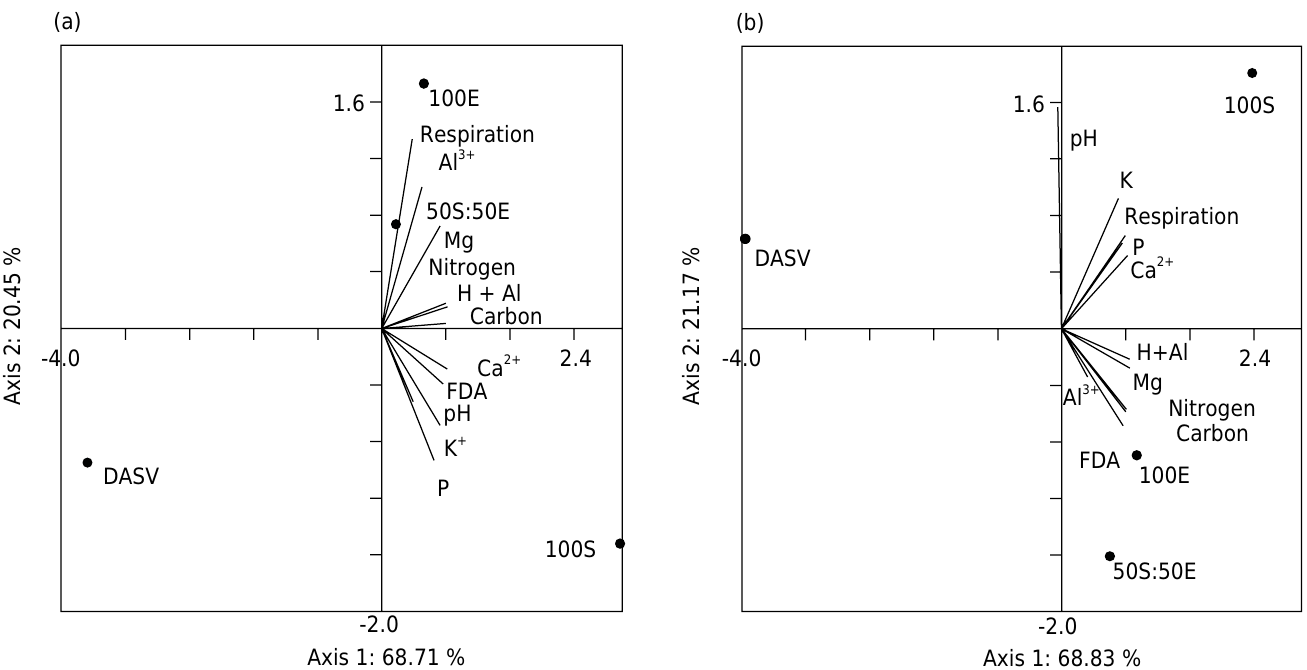
Figure 2. Principal component analysis integrating chemical and microbiological characteristics of degraded area with spontaneous vegetation (DASV) and degraded areas reforested with Sesbania virgata and Eucalyptus camaldulensis in monospecific (100S and 100E, respectively) and mixed species (50S:50E) stands in the rainy (a) and dry (b) seasons.